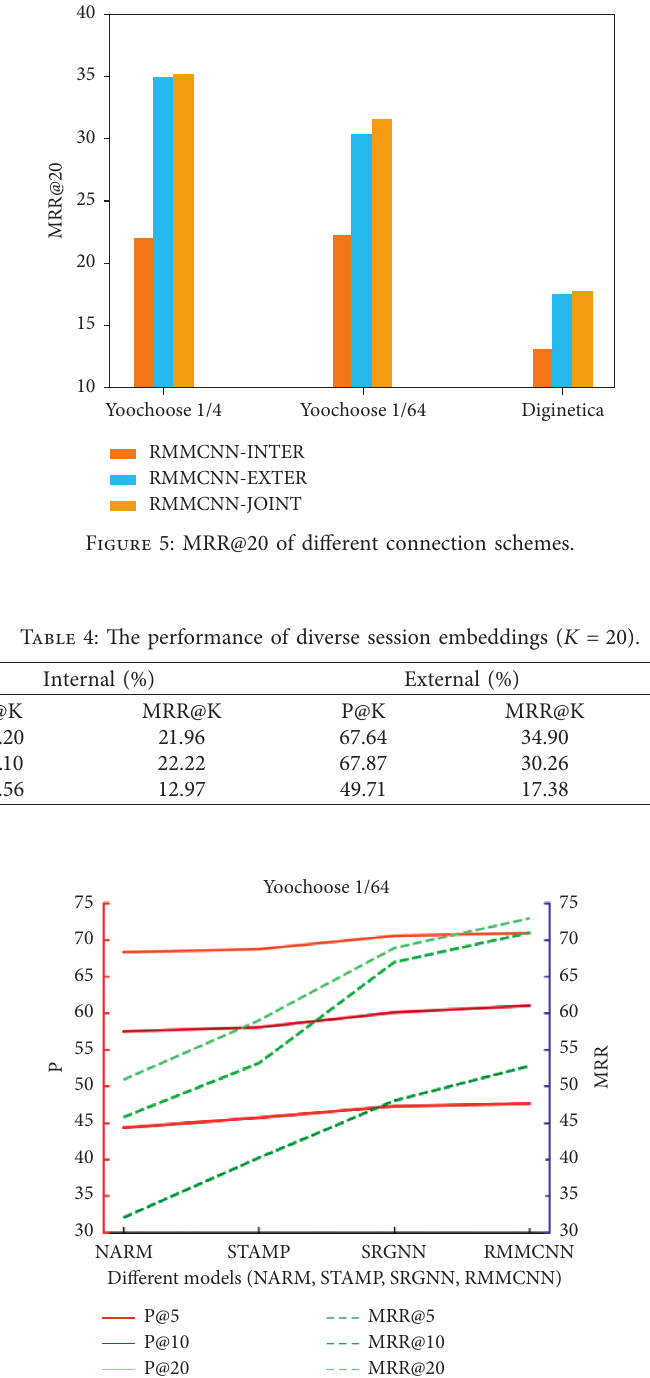
Figure 6: The Precision and MRR of different K settings on Yoochoose 1/64.